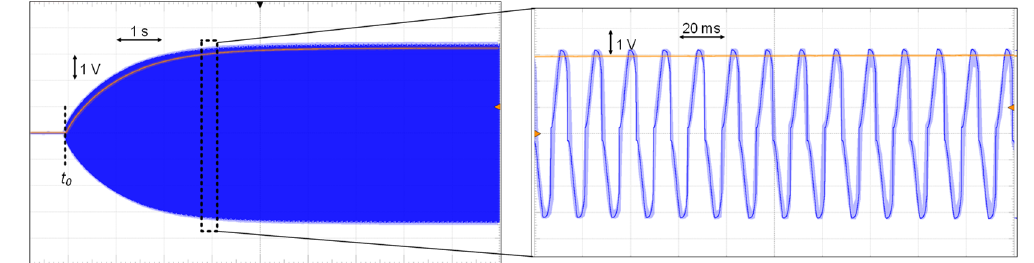
( b ) Figure 13. Measured waveform of the PE voltage V BA and the rectified voltage V rect ( a ) in the P- SSHI mode, and ( b ) in the S-SSHI mode.